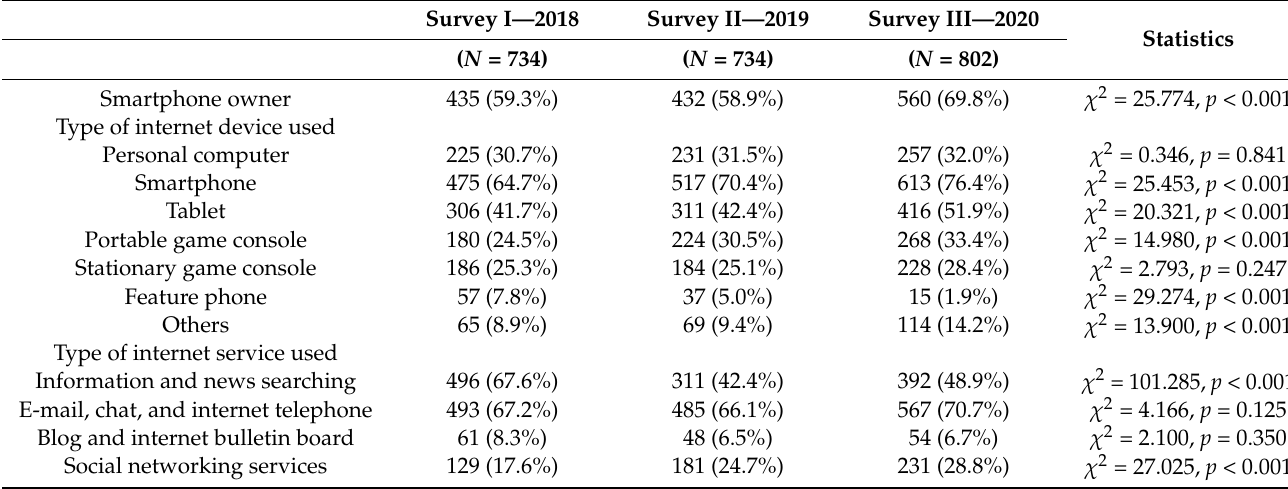
Table 2. Comparisons of smartphone ownership, type of internet device used, type of internet service used, average duration of daily internet use, and YDQ score between the